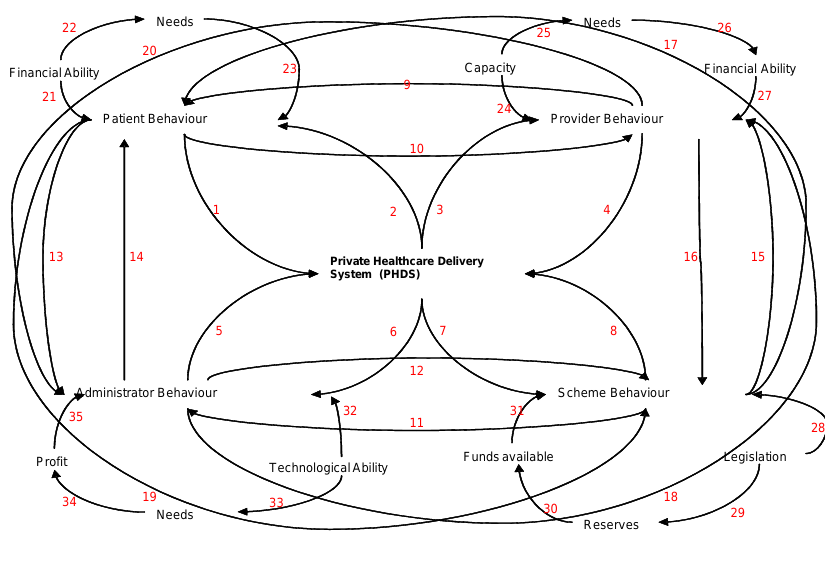
Figure 8: A system’s perspective of the PHDS The PHDS within the environment